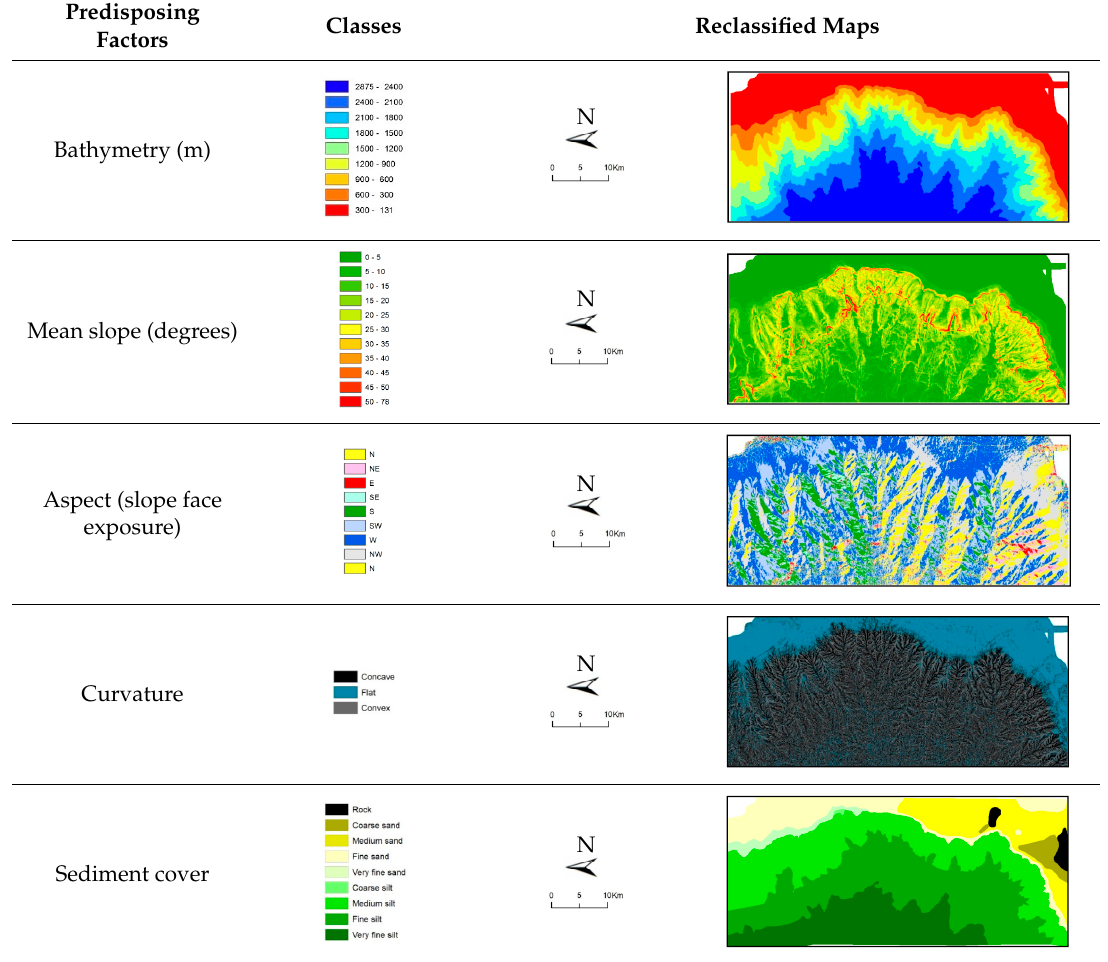
Table 1. Predisposing factors surfaces and its respective classes.